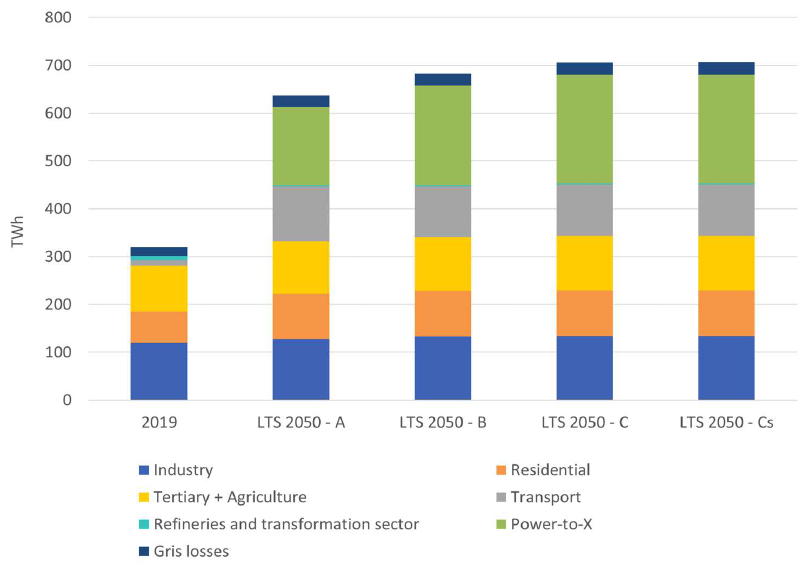
Figure 10. Evolution of electricity consumption in the 2050 LTS scenarios.